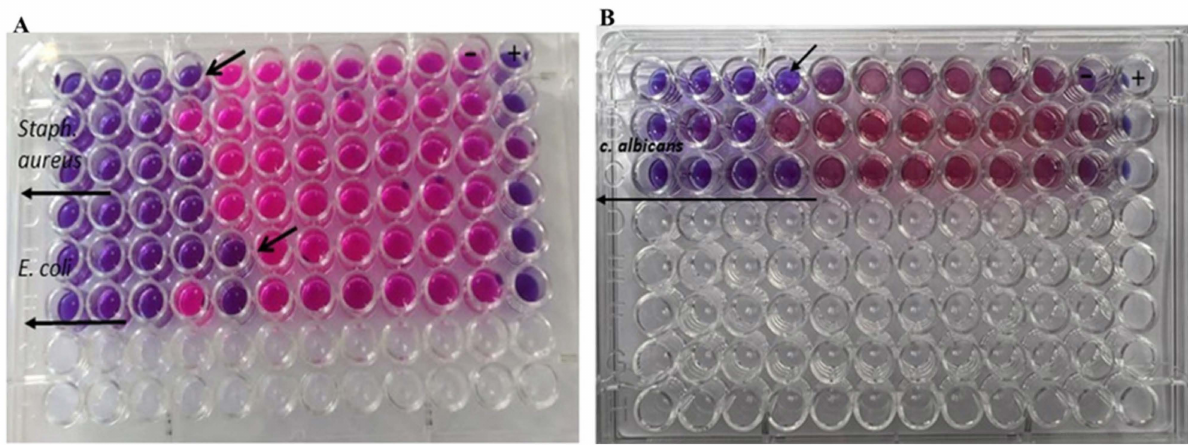
Figure 5. Representative MIC using resazurin dye for ( A ) S. aureus and E. coli and ( B ) for C. albicans